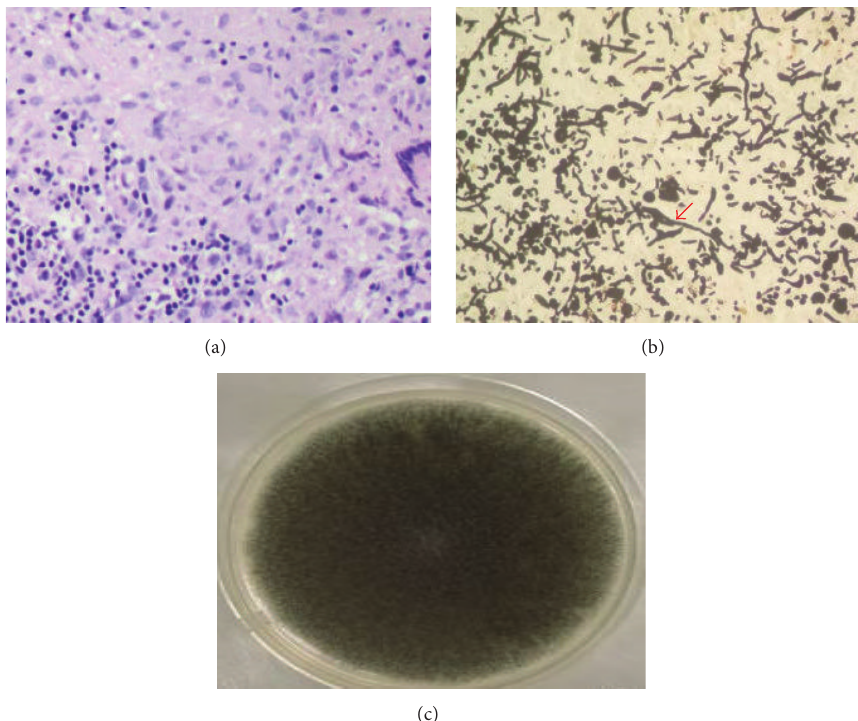
Figure 6: Microbiological features suggested aspergillosis caused by niger